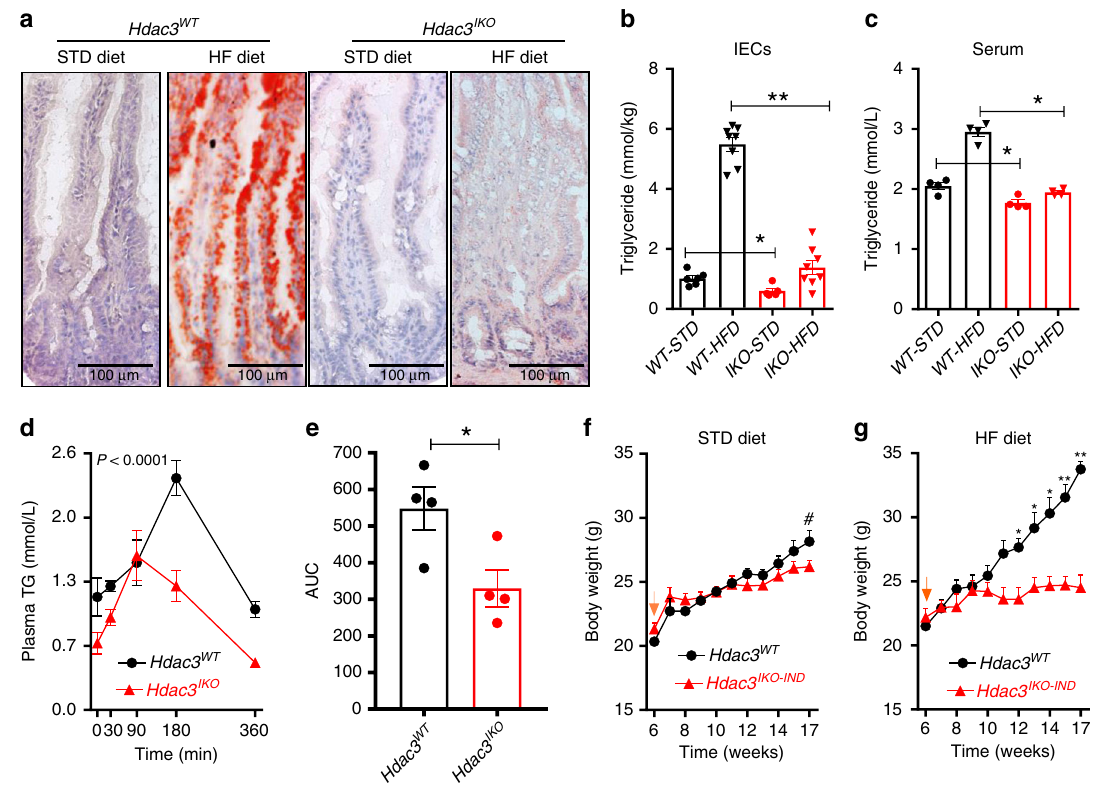
Fig. 5 HDAC3 deletion reduces enterocytic triglycerides and protects against diet-induced obesity. a Oil Red staining of neutral lipids in the intestinal epithelium of 8 – 12-week-old Hdac3 WT and Hdac3 IKO male mice fed a standard (STD) or high-fat diet (HFD) for 4 weeks. b , c Triglyceride levels in ( b ) IECs or ( c ) serum from these mice. Values shown are mean ± SEM of n = 6 for mice fed a standard diet and n = 8 for mice fed a HFD, * P < 0.05, ** P < 0.005, unpaired t test. d Lipid tolerance test of Hdac3 WT and Hdac3 IKO male mice fed a HFD for 4 weeks, and ( e ) corresponding area under the curve calculation. Values shown are mean ± SEM of n = 4 mice per genotype. f , g Difference in weight gain of 4 – 6-week-old Hdac3 WT and Hdac3 IKO-IND male mice fed a ( f ) standard (STD) or ( g ) HFD for 11 weeks. Mice were injected with tamoxifen at 6 weeks (orange arrow) to induce Hdac3 deletion and body weight monitored for the following 11 weeks. Values shown are mean ± SEM of n = 4 mice each genotype. * P < 0.05, ** P < 0.005, t test, # P < 0.05, one-sided unpaired t